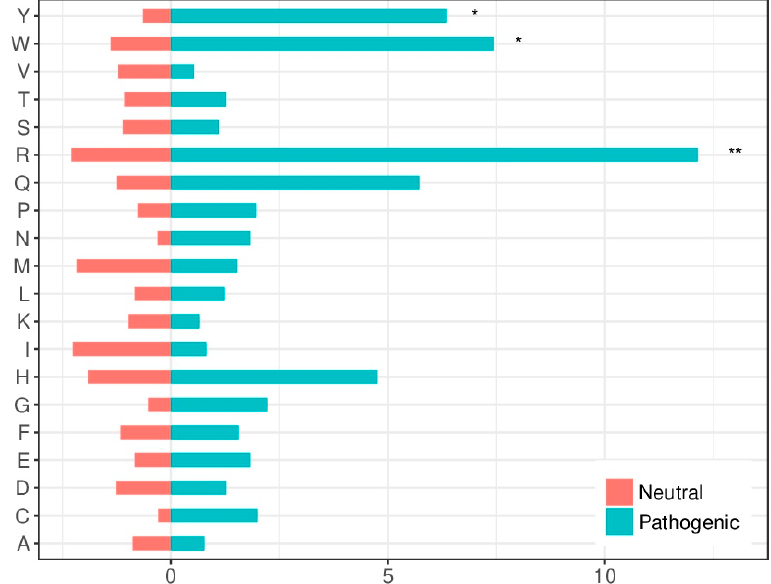
Figure 3. Amino acid substitution susceptibility to disease-causing or neutral variants within protein interfaces. The bars show the percentage of residues of a given type that are found mutated in disease-causing variants (in blue) or neutral variants (in red). Asterisks show statistical significance according to a “ N-1 ” χ 2 test (* 0.01 < p < 0.05; ** 0.001 < p < 0.01).